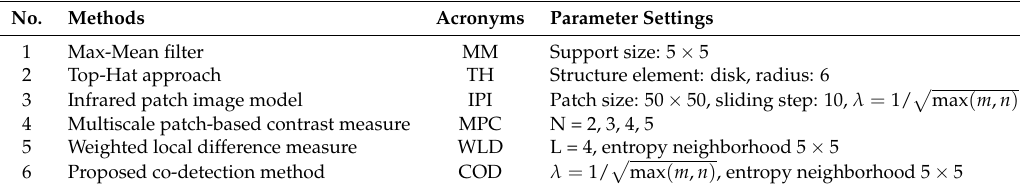
Table 4. Detailed parameter settings of the six test methods.